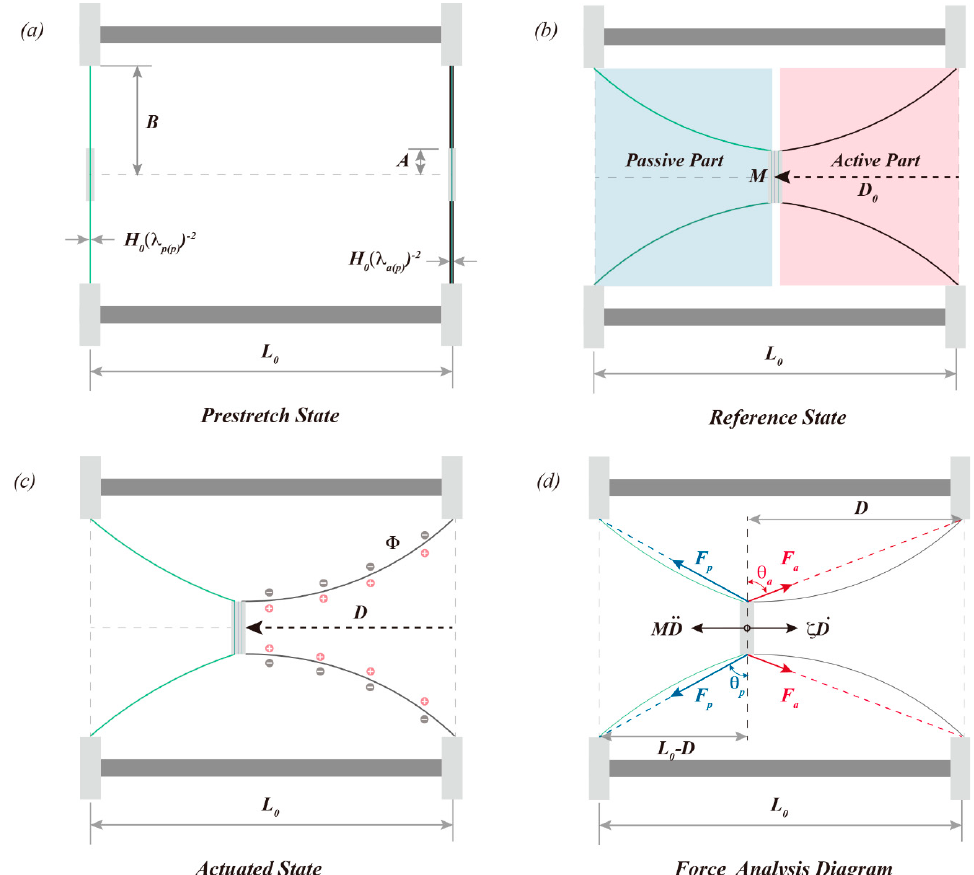
Figure 2. Diagram of the push-pull DEA states and mass block force analysis: ( a – c ) are the pre-stretch, reference, and actuation states, respectively, of the push-pull DEA; ( d ) is the force analysis diagram of the mass block in the actuator.